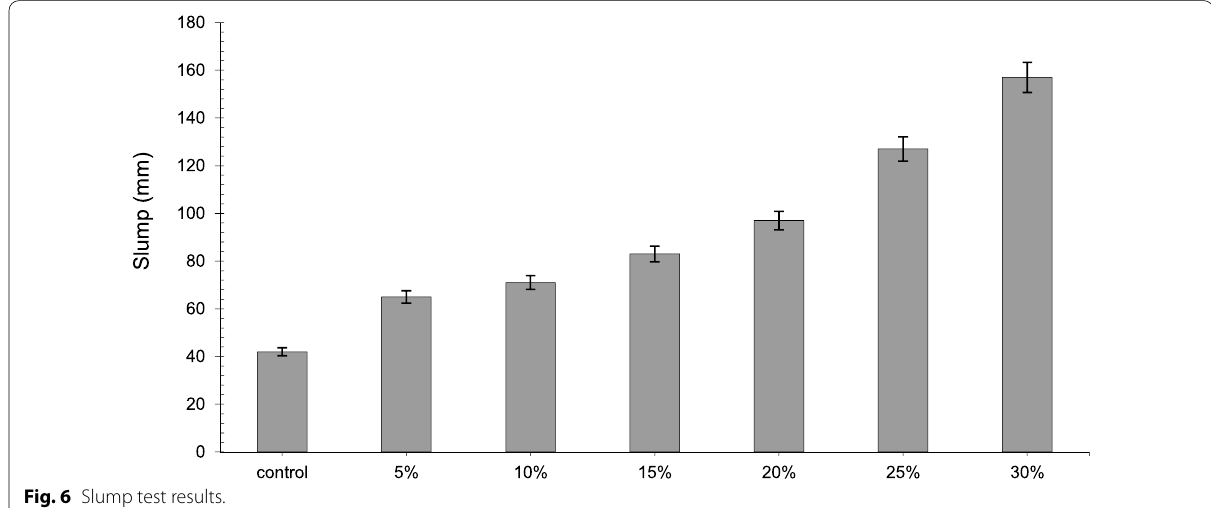
Fig. 6 Slump test